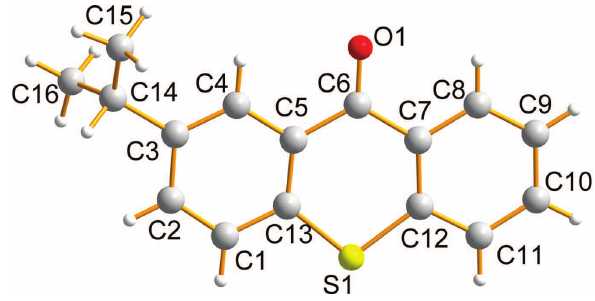
Table 1: Data collection and handling.